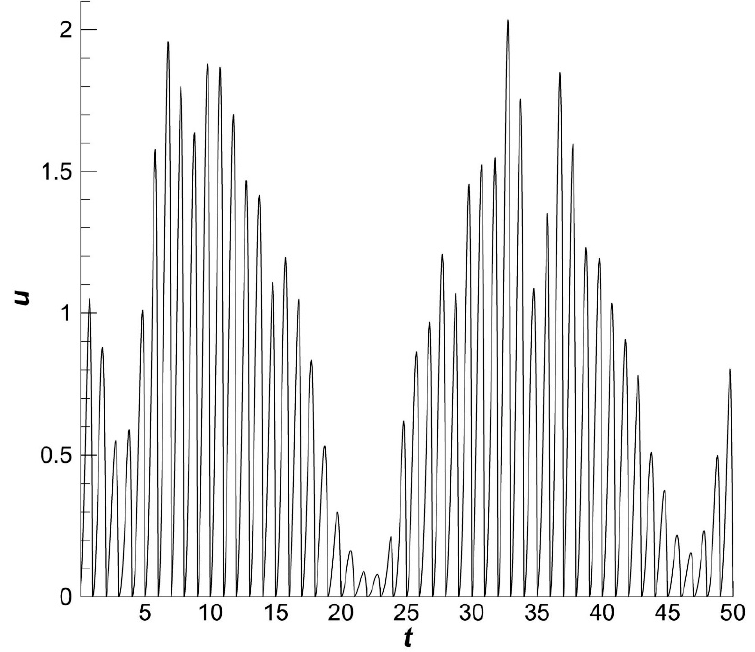
Figure 4. Dynamics of fishery effort u ( t ) .